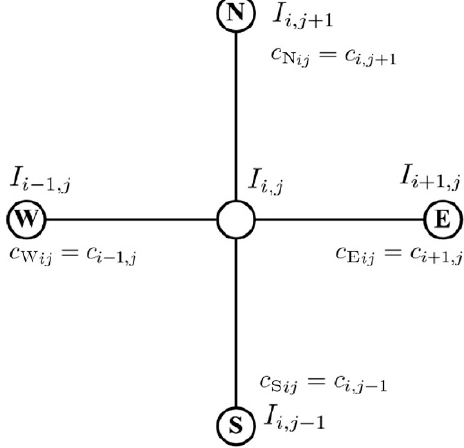
Fig. 1 The discretization scheme of the divergence operator